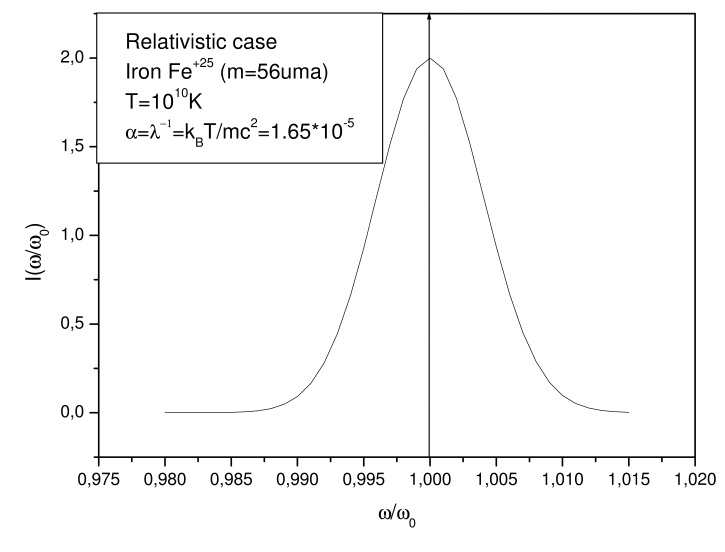
Figure 2. Relativistic intensity as defined by Formula (19) for Iron at T = 10 10 K.